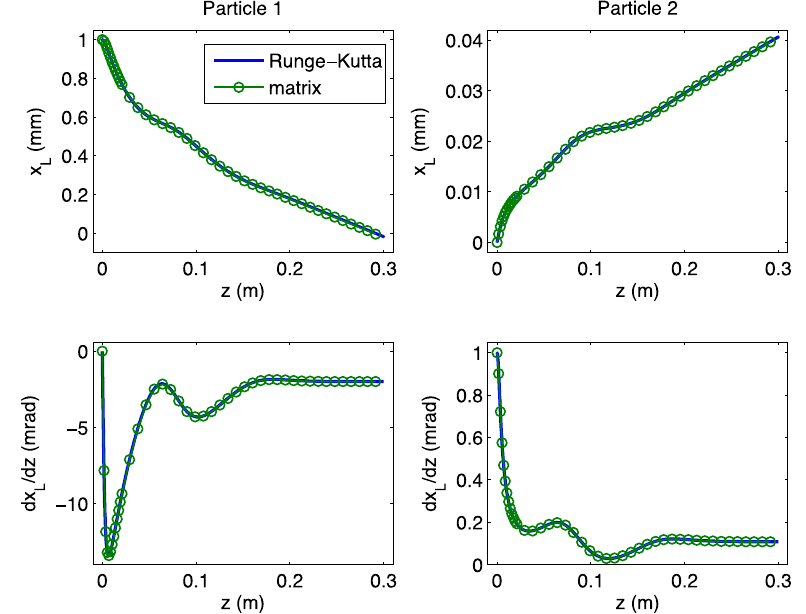
FIG. 6. Comparison of direct integration (blue) and tracking using the transfer matrix (green) of the two principle